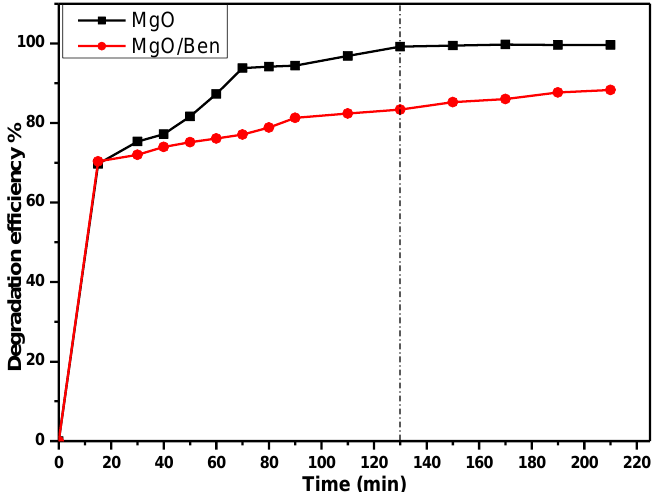
Figure 8. Contact time effect of MgO NPs (0.20 g) and MgO/Ben nanocomposite (0.15 g) on the photocatalytic degradation of CV (10 mg L − 1 ) under stirring rate of 300 rpm at pH 7. Table 2. Effect of different contact times on the degradation efficiency of CV dye by using MgO NPs and MgO/Ben nanocomposite as a photocatalyst. Contact Time (min)